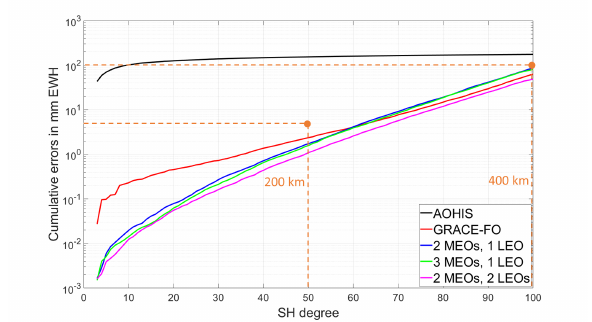
Fig. 6. Cumulative signal of full AOHIS (black) and cumulative errors of different mission scenarios, when including only instrument errors. The threshold science requirements for 400 km (SH degree 50) and 200 km (SH degree 100) are included in orange colour.